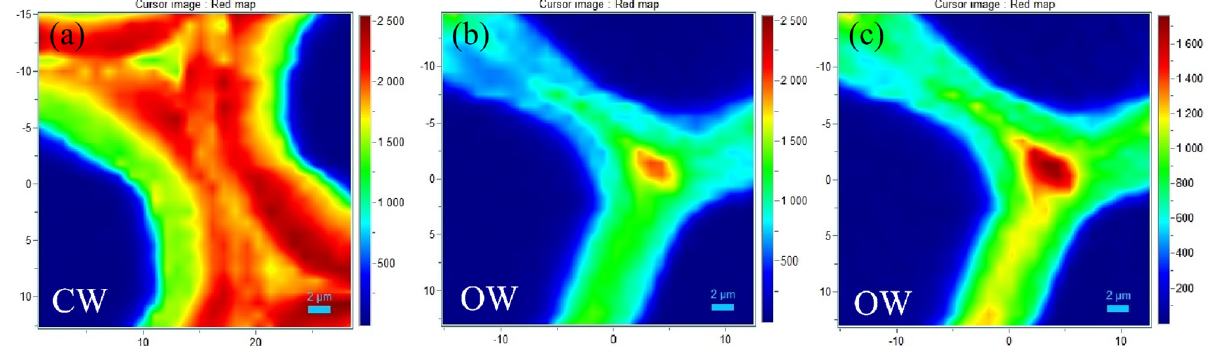
Figure 11. Raman images of lignin in the cell wall of CW and OW. For comparison, Figure ( b ) is adjusted to the same color scale as Figure ( a ) to obtain Figure ( c ). The lignin concentration in CC of OW (red, 2000 intensity units) is higher than that in CC of CW cell (yellow, 1750 intensity units), but lower than that in the S2L layer of the CW cell wall (dark red, 2250–2500 intensity units).